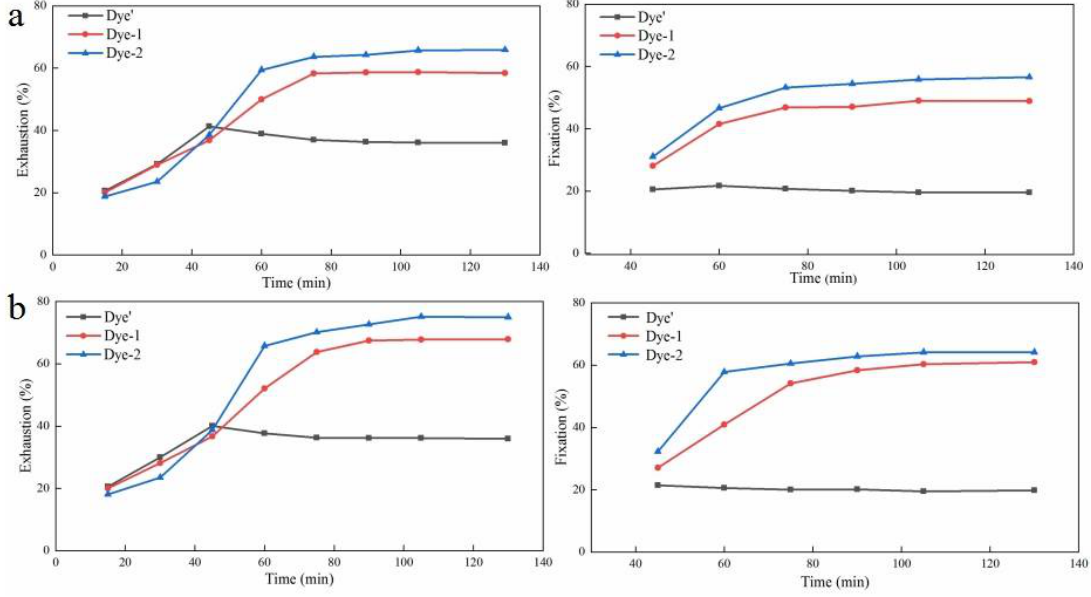
Figure 3. ( a ) Fixation and exhaustion of dyes with added sodium sulfate. ( b ) Fixation and exhaustion of dyes without adding sodium sulfate. of dyes without adding sodium